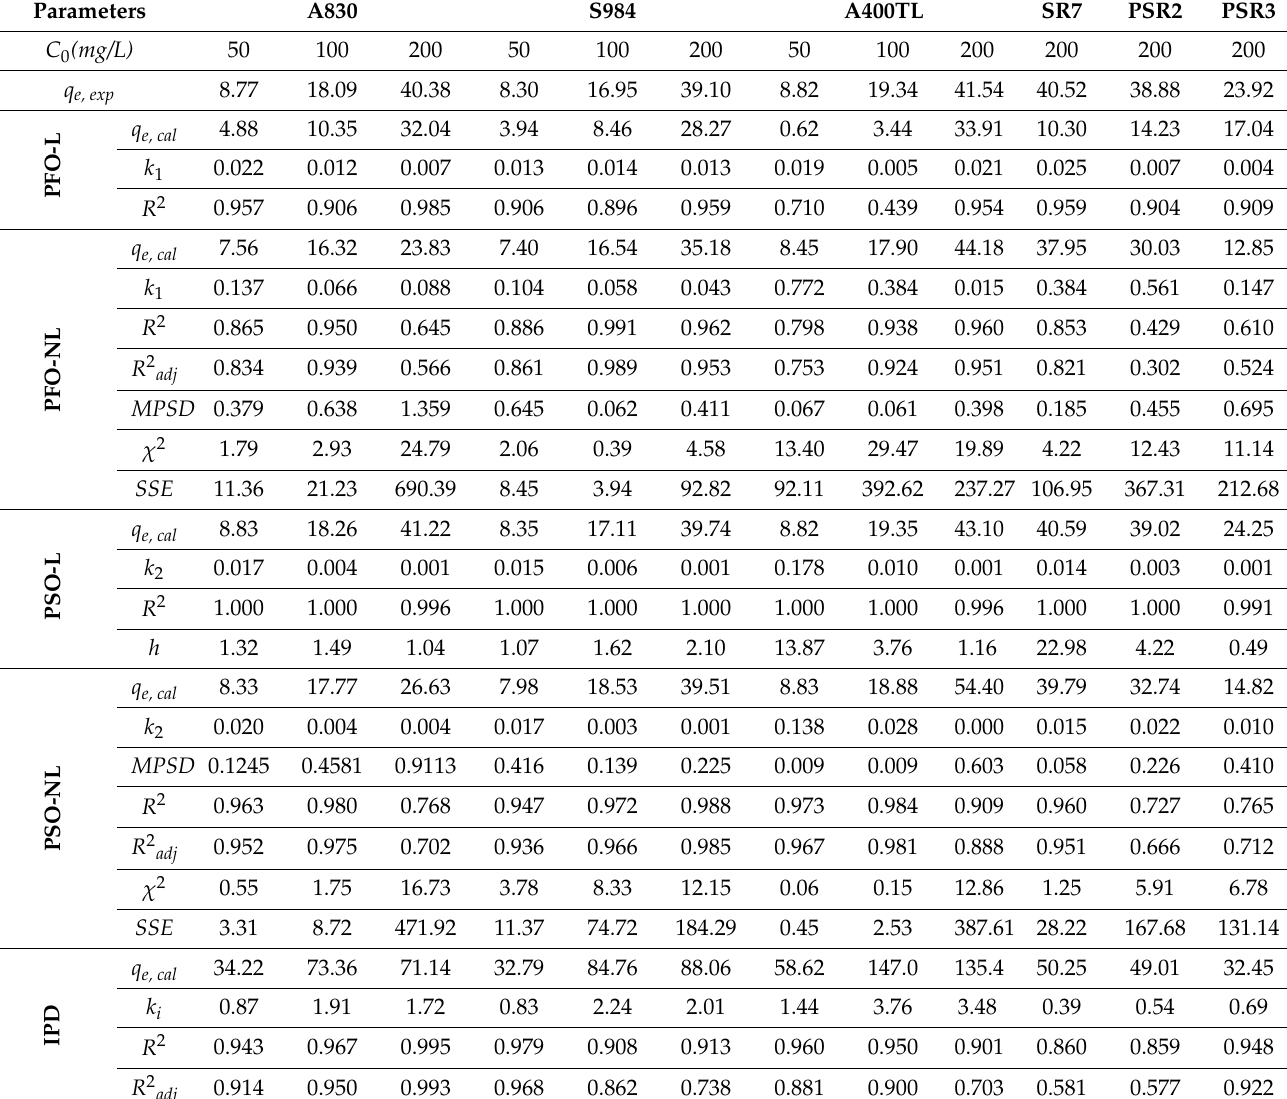
Table 3. Comparison of kinetic parameters obtained during the V(V)